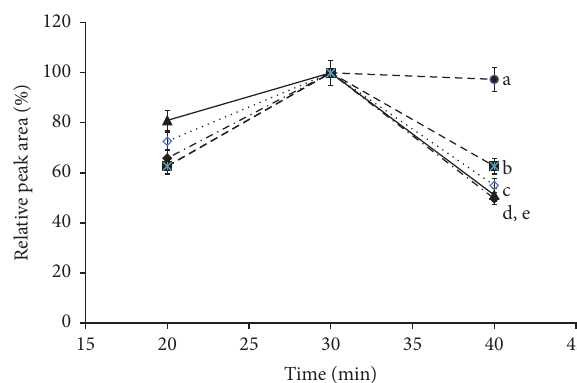
Figure 2: Effect of ultrasonic time on some polycyclic aro- matic hydrocarbons release from tea infusion to organic phase. a: benzo[ghi]perylene;b:indeno[1,2,3-cd]pyrene;c:benzo[b]fluorant- hene; d: benzo[a]pyrene; e: